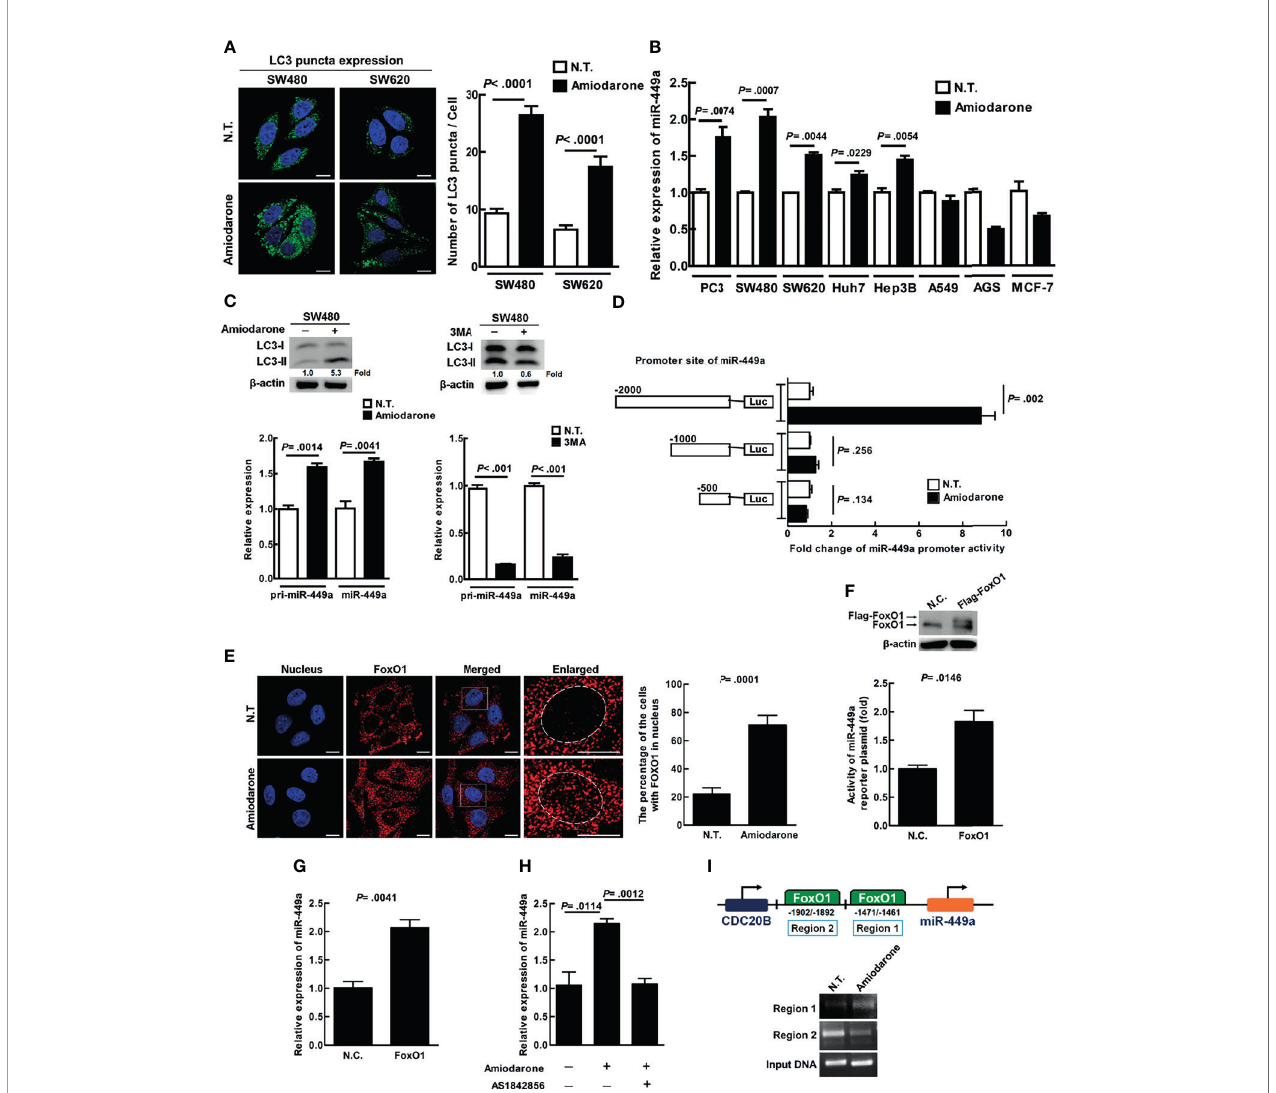
FIGURE 2 | Autophagy positively regulates miR-449a expression at the transcriptional level through FoxO1 binding at region 1 of the promoter in CRC cells. (A) SW480 and SW620 cells were treated with amiodarone (10 m M) for 48 h. Anti-LC3 antibody and Hoechst stain were used to label the treated cells for LC3 puncta and nuclei, respectively. Cells were investigated under a confocal microscope. Quanti fi cation of LC3 puncta was conducted by randomly counting 30 cells. The data represent means ± SEM. (B) The expression of miR-449a was determined by real-time RT – PCR under amiodarone (10 m M) treatment for 48h in colorectal (SW480 and SW620), prostate (PC3), liver (Huh7 and Hep3B), breast (MCF-7), lung (A549), and gastric (AGS) cells. U54 was used as an endogenous control to normalize miR-449a expression. (C) SW480 cells were treated with amiodarone (10 m M) for 48 h or treated with the inhibitor 3MA (10 mM) for 24 h followed by immunoblotting to determine LC3 protein level. The levels of pri-miR-449a and miR-449a in SW480 cells were measured by real-time PCR. (D) Schematic diagram shows the miR-449a reporter plasmids constructed. The cells were transiently transfected with the constructed plasmid pGL3-basic-500, 1000 or 2000 bp. The relative luciferase activities were measured after normalization with renilla luciferase activity with or without amiodarone (10 m M) treatment for 48 h. (E) Localization of FoxO1 and nucleus was shown using anti-FoxO1 antibody and Hoechst staining, respectively. The cells were investigated under a multi-photon confocal microscope and quanti fi ed by randomly counting 50 cells. (F) SW480 cells were transiently transfected with FoxO1 plasmid (4 m g, pcDNA3/FLAG-FoxO1) by Lipofectamine ™ 2000 for 48 h. The expression of FoxO1 was measured using anti-FoxO1 antibody by immunoblotting. The activity of miR-449 reporter plasmid was measured by luciferase assay. (G) The expression of miR-449a was measured after the cells were transiently transfected with FoxO1 plasmid DNA (8 m g) for 48 h by real-time PCR. (H) The cells were treated with amiodarone (10 m M) in the presence or absence of FoxO1 inhibitor AS1842856 (40 nM) for 48 h. The expression of miR-449a was determined by real-time PCR. (I) SW480 cells after amiodarone (10 m M) treatment for 24 h were fi xed with formaldehyde followed by immunoprecipitation with anti-FoxO1 antibody. The DNA in the immunoprecipitate was ampli fi ed using the primer sets encompassing region 1 and 2 of miR-449a promoter region. Student ’ s t -test analysis was conducted and p-value ≤ 0.05 represents signi fi